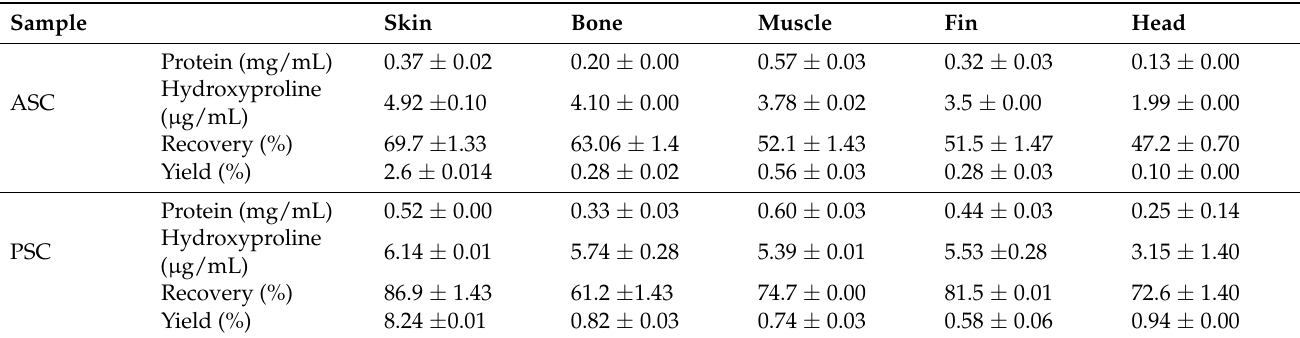
Table 2. Protein recovery, hydroxyproline content, recovery, and yield of acid-soluble collagen (ASC) and pepsin-soluble collagen (PSC) from catfish